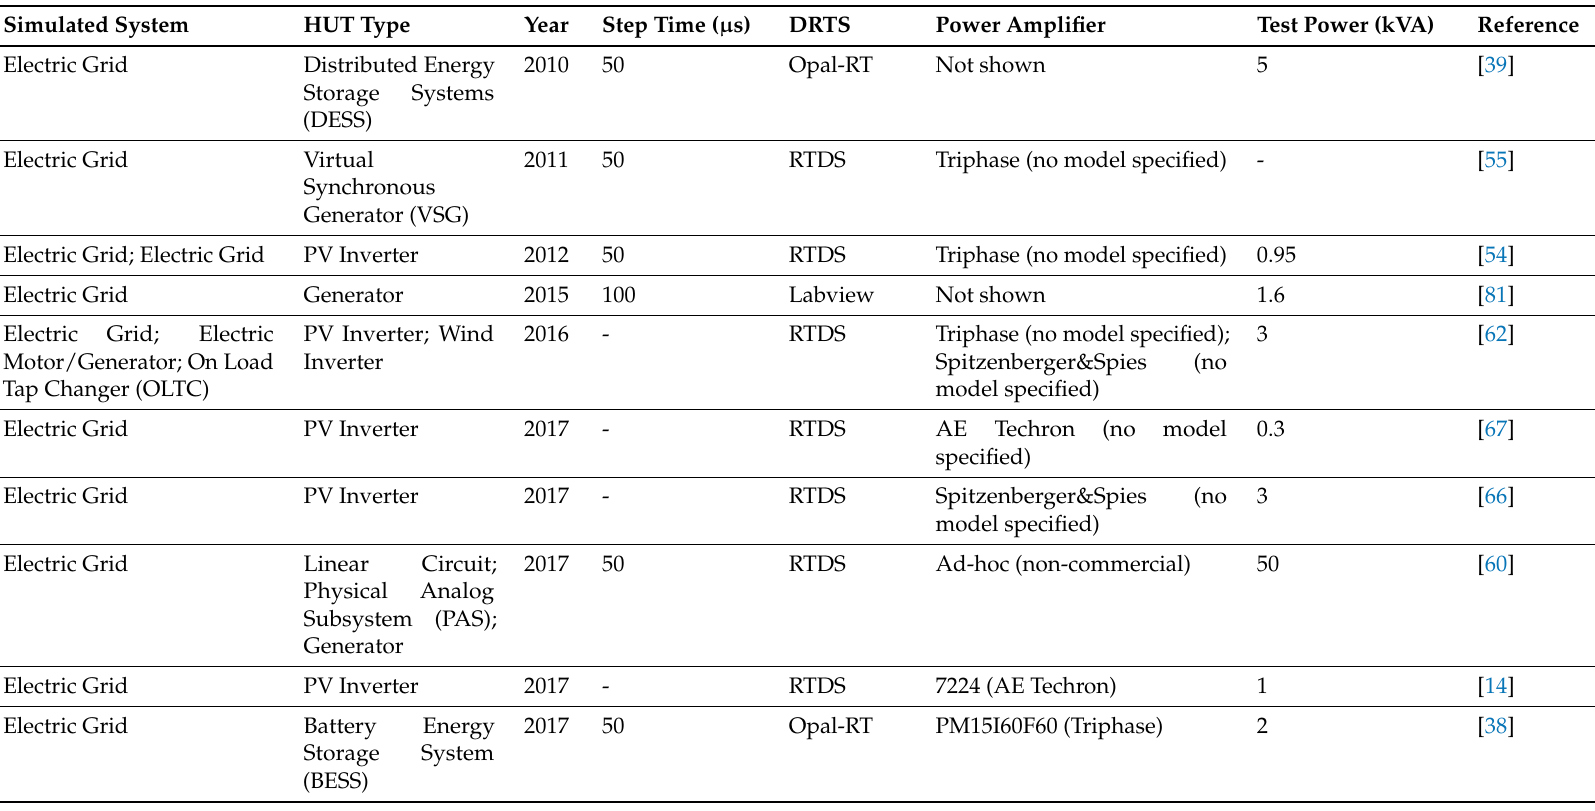
Table 4. Database query result for a Smart Grid application; Filtering process using the fields “Simulated Systems”,”Test Power” and “Step